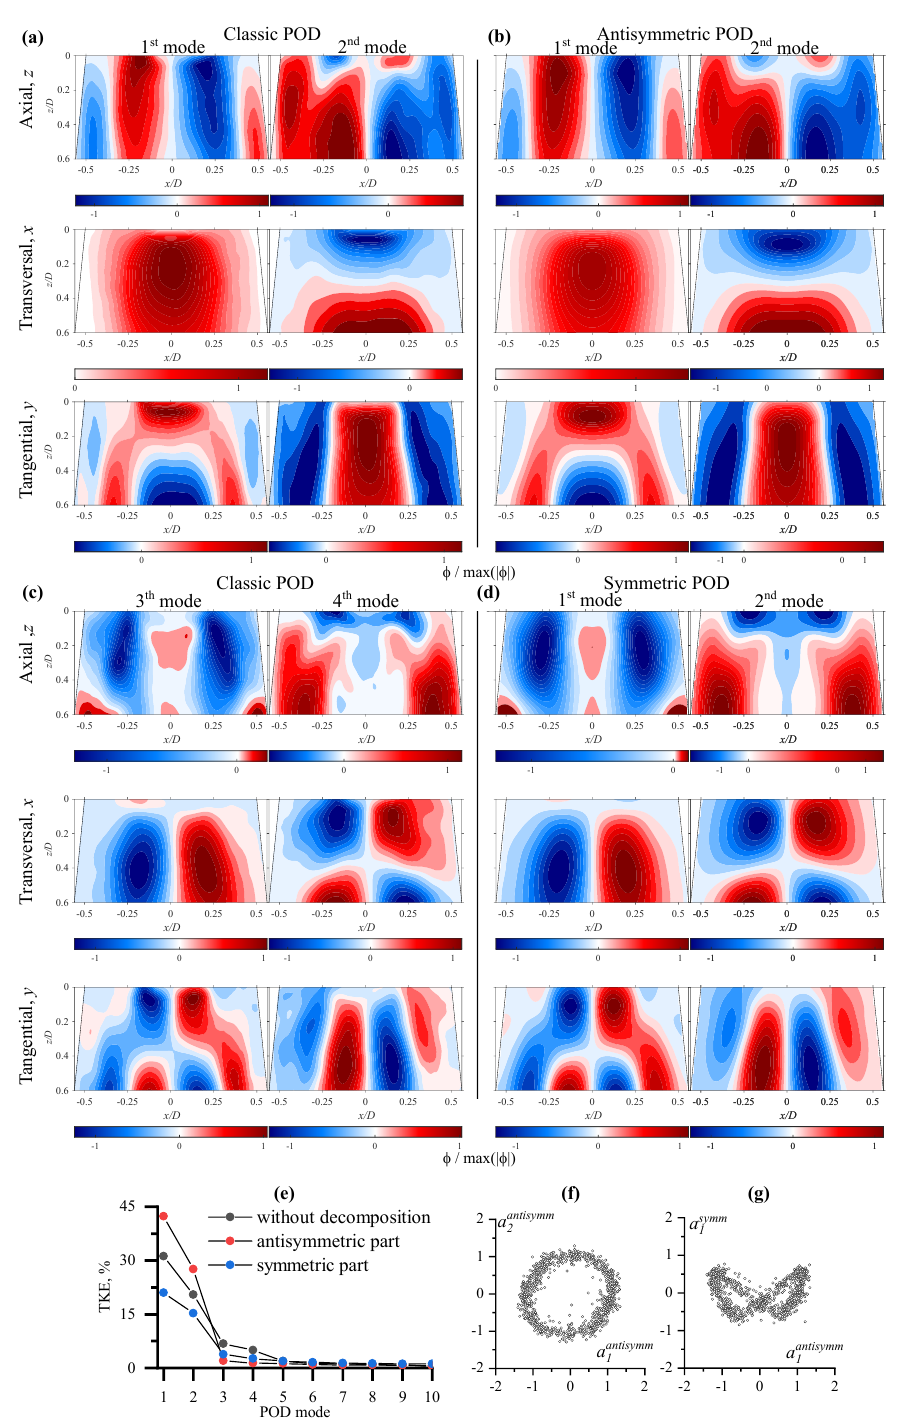
Figure 6. Comparative POD analysis of the flow snapshots decomposed in symmetric/antisymmetric parts (right column) and without decomposition (left column) for all three components of velocity fields: 1st and 2nd modes of classical POD analysis ( a ); 3rd and 4th modes of classical POD analysis ( c ); 1st and 2nd modes of antisymmetric POD ( b ), 1st and 2nd modes of symmetric POD ( d ), TKE content of POD modes ( e ), Lissajous figure of a antisymm ( g ). Flow rate is 0.5 Q